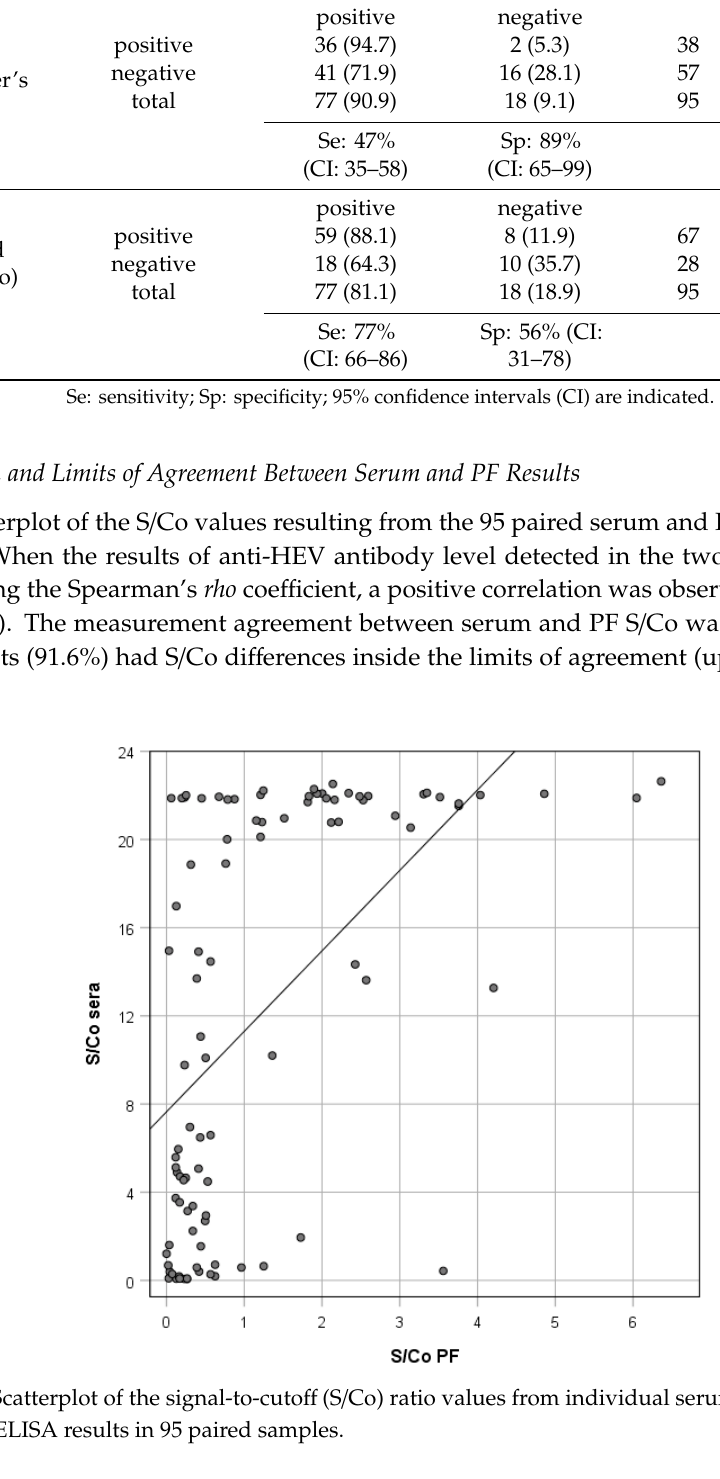
Table 2. Agreement between processing fluids (PF) and sera-based HEV ELISA results at the individual level.